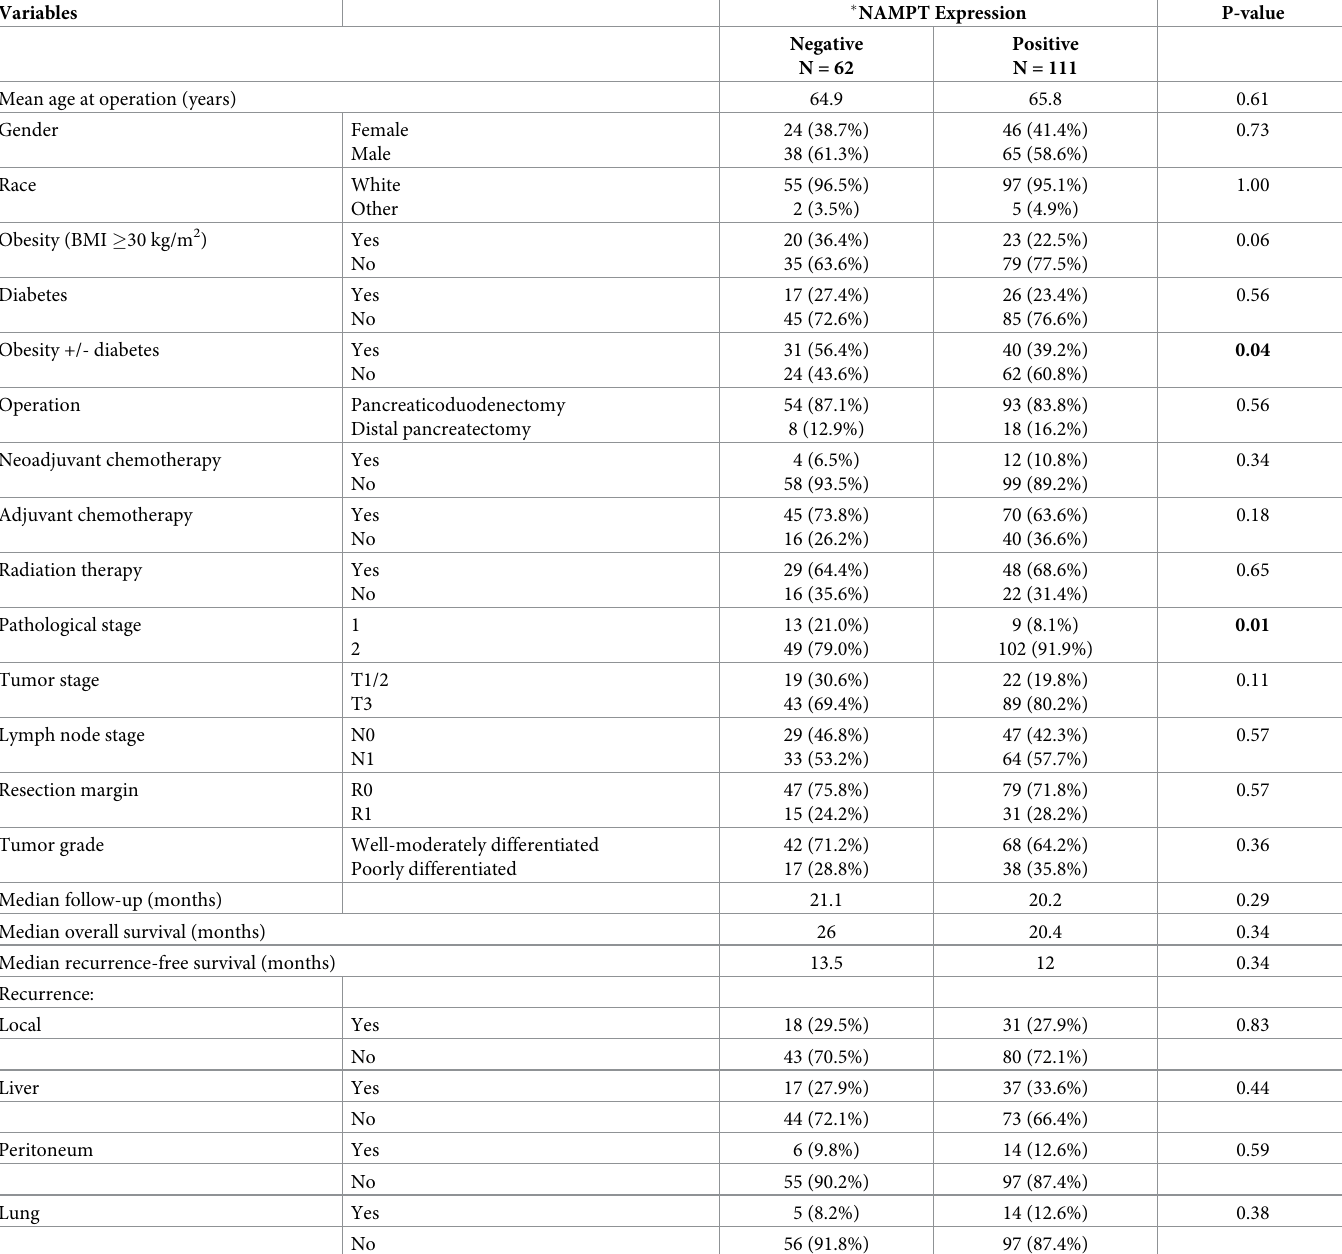
Table 2. NAMPT IHC score in